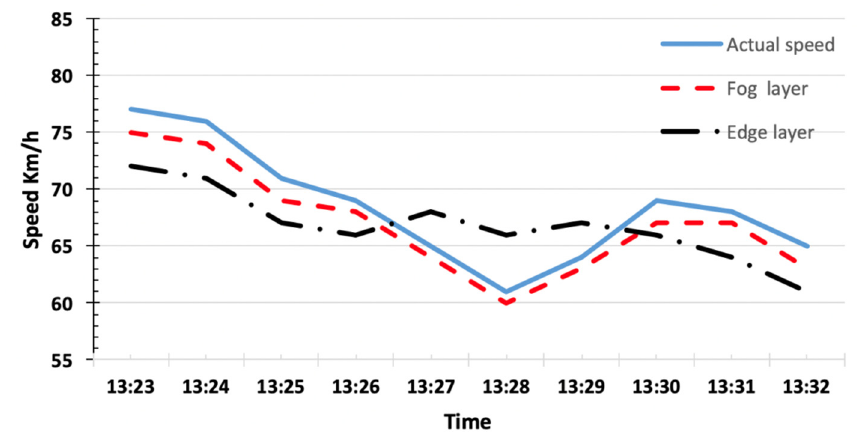
Figure 7. Speed estimation using smartphone 1, which shows a comparison of estimation between the baseline (edge computing alone) and the proposed system (edge + fog layers). The proposed system’s estimation is more accurate than that of the baseline.